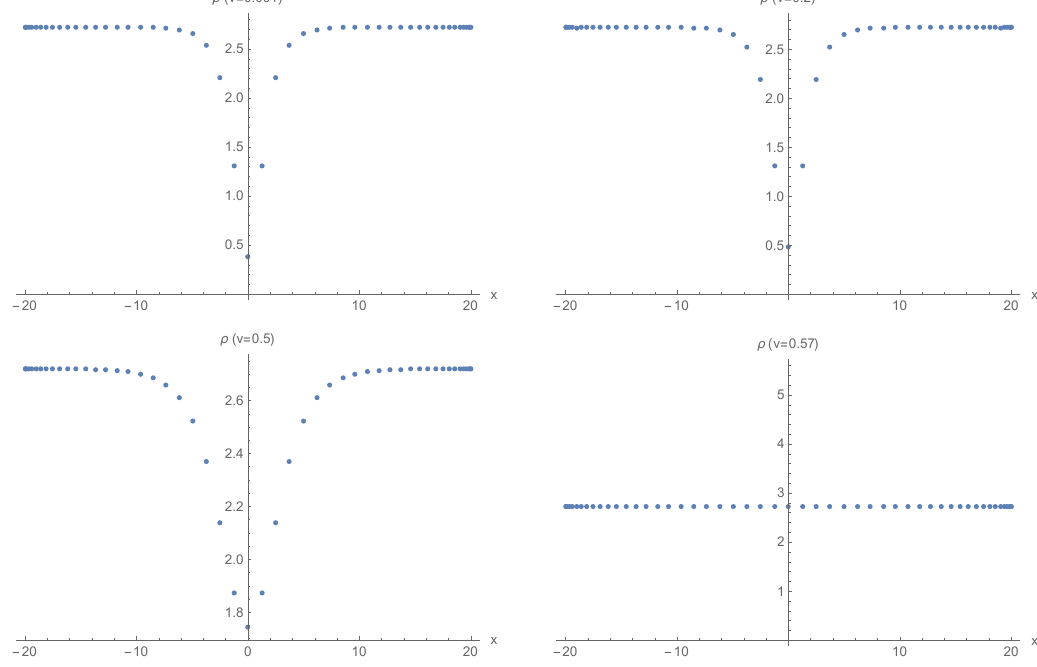
are in sequence (cid:26) x =20